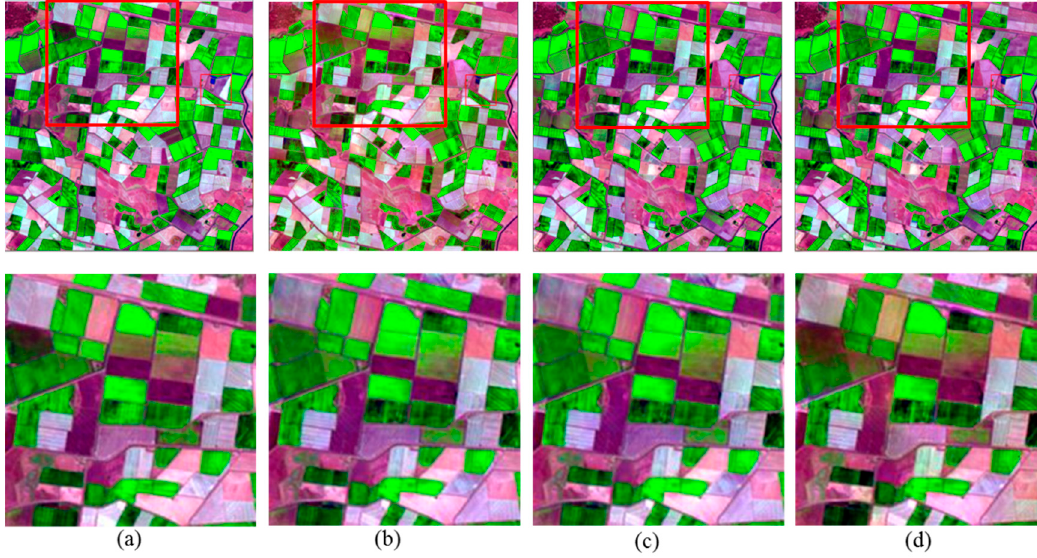
Figure 8. Fusion results on the 8th date of the CIA site. Top row shows the zoomed ground truth in the red rectangle of Figure 6e and the corresponding fusion results. Bottom row shows the zoomed ROIs in the red rectangle of images in the top row. ( a ) the ground truth Landsat image; ( b ) the fusion result of SRSTF; ( c ) the fusion result of CNNSTF; ( d ) the fusion result of VDCNSTF.